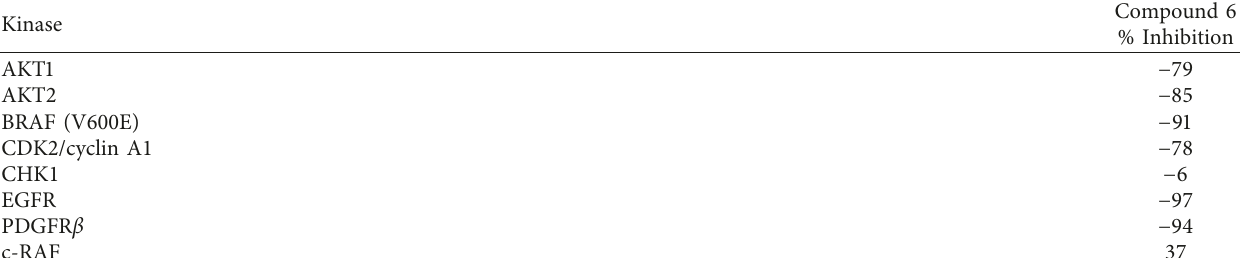
Table 1: Percentage of kinase inhibition of derivative 6 at 100 μ M.